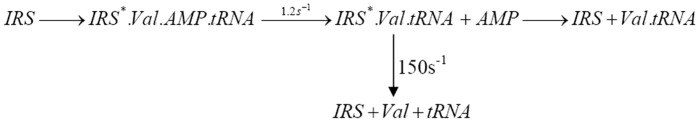
Schematic representation of one of the two kinetic proofreading mechanisms (mechanism I) proposed by Fersht.Here formation of Val-tRNAIle is the rate limiting step (k = 1.2 s−1) and it is followed by rapid hydrolysis of the complex.